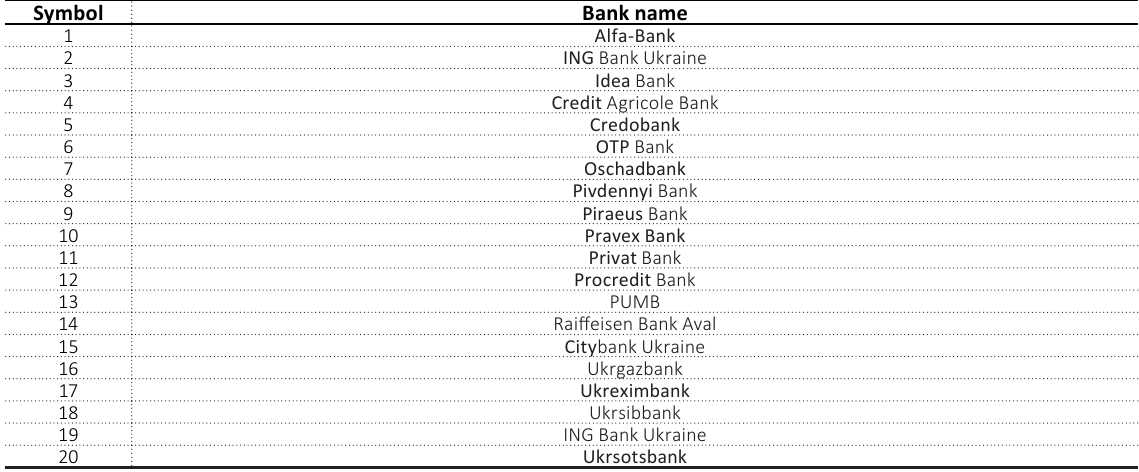
Table 3. Banks that have disclosed their non-financial reports for 2016–2018